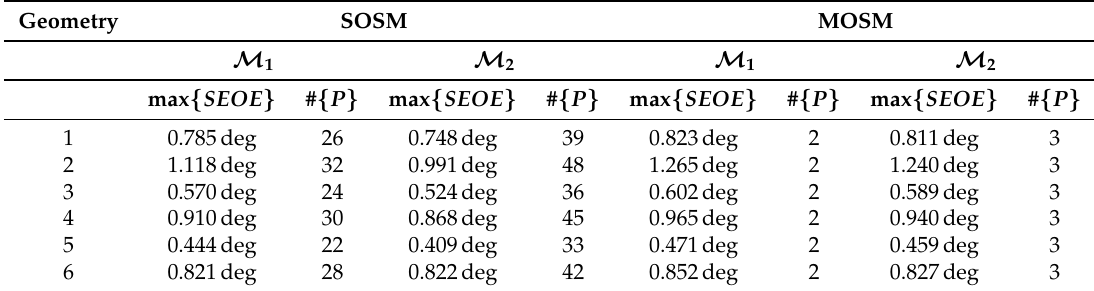
Table 3. The results of model evaluations for different model approaches, strategies, and considered geometries as well as the amount of necessary